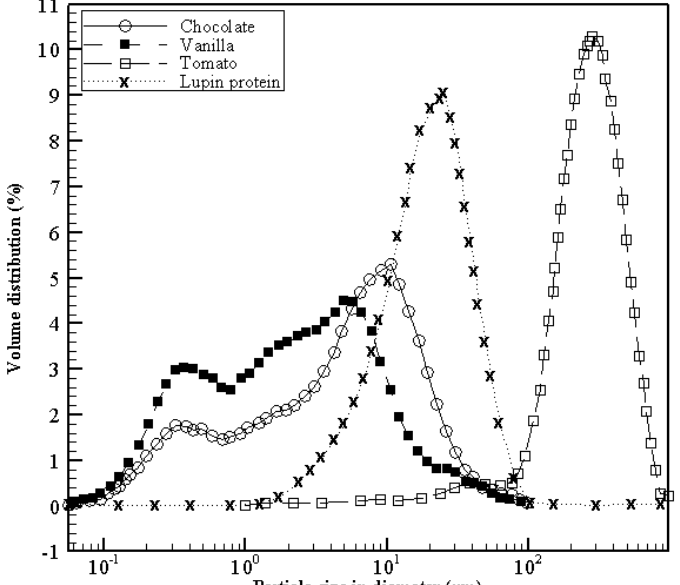
Figure 2: Particle size distribution of the control (0 MPa) based products of chocolate- and vanilla-based products, tomato and lupin protein [1, 5,